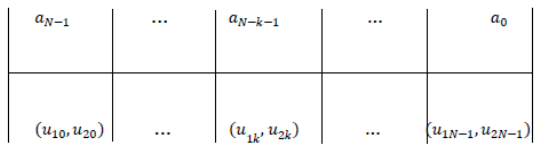
Figure 2. Strategies computed on k th interval.